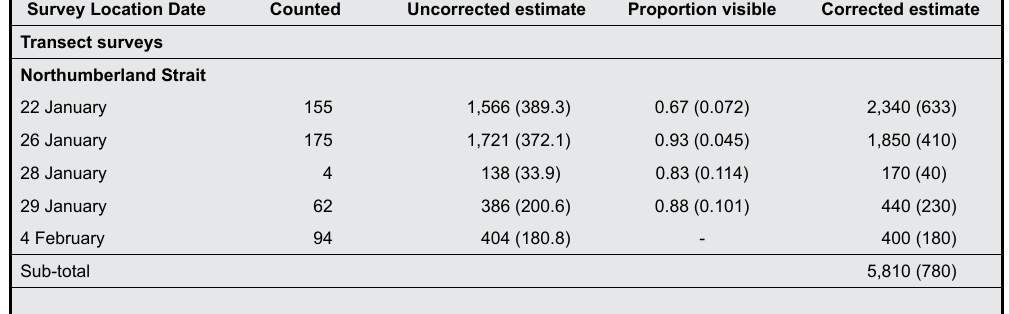
Table 4 . Uncorrected pup production estimates, correction factors and corrected pup production estimates for surveys in January and February 1997. Correction factors were not applied to island counts. Standard errors are in parentheses. Corrected estimates are rounded to the nearest 100.